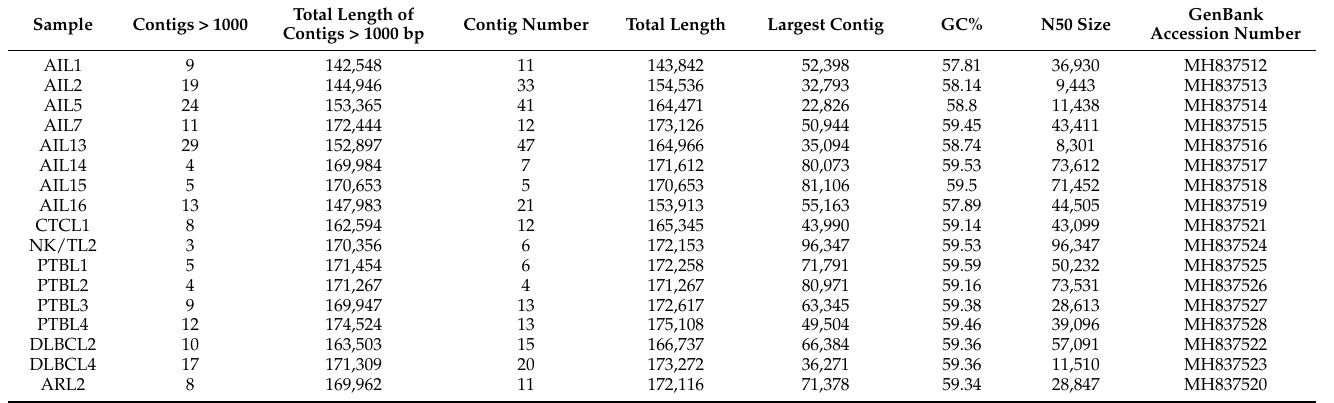
Table 3. Characteristics of EBV Genome Sequences Created by Contig de novo Assembly and GenBank Accession Number for 17